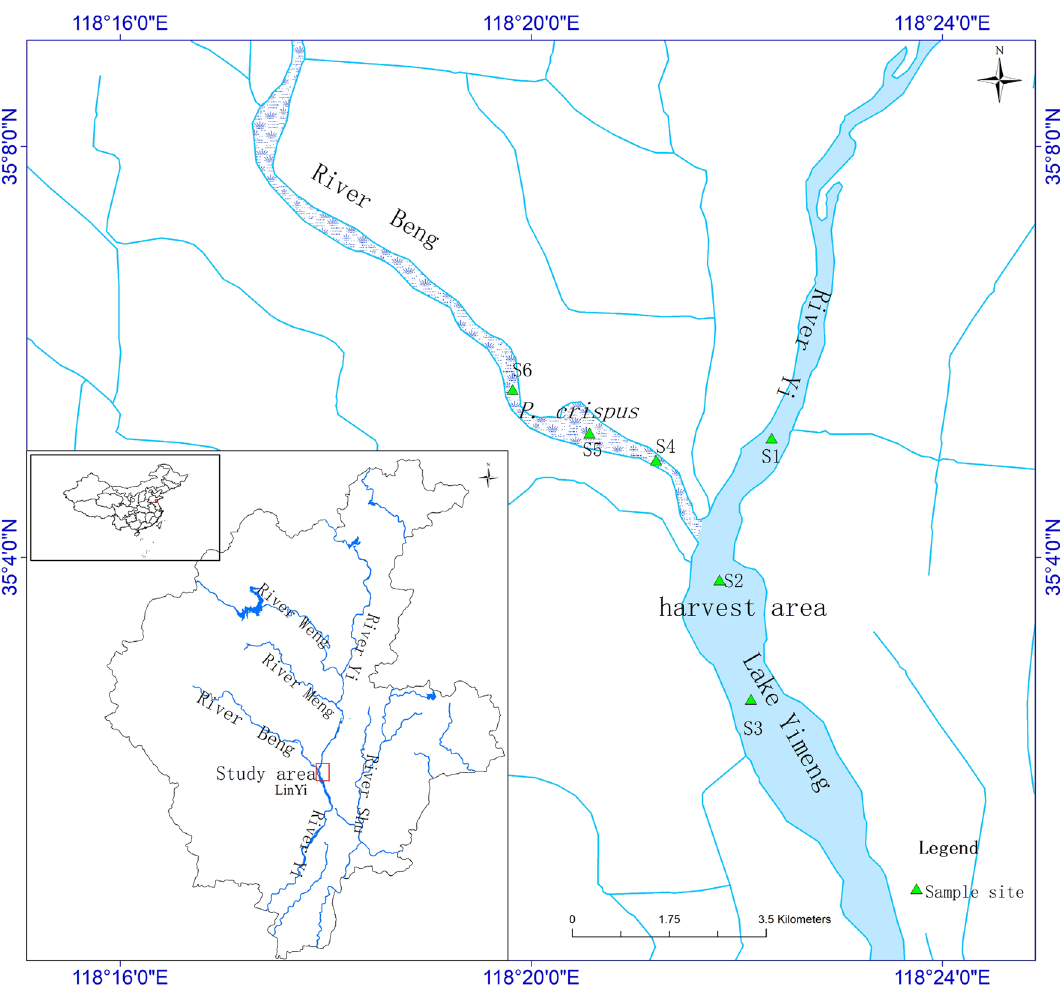
Figure 1. Location of studied area and its sampling sites. Map (https:// www. esri. com/) generated using ArcMap version